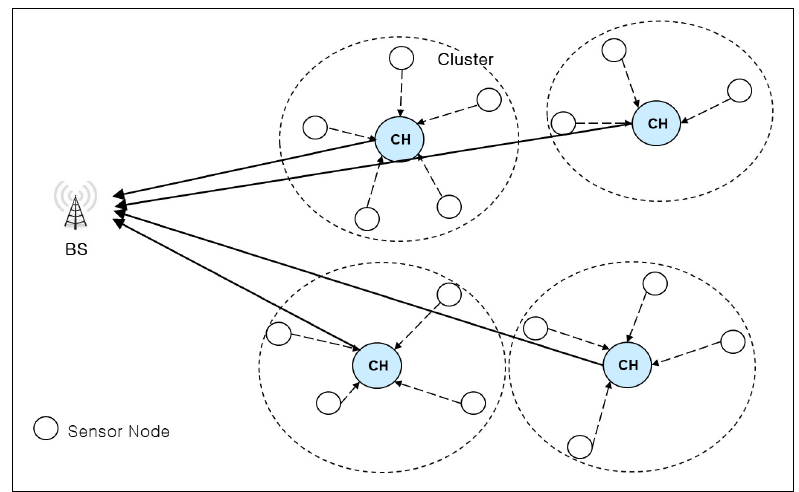
Figure 5. Steady-state phase of LEACH.